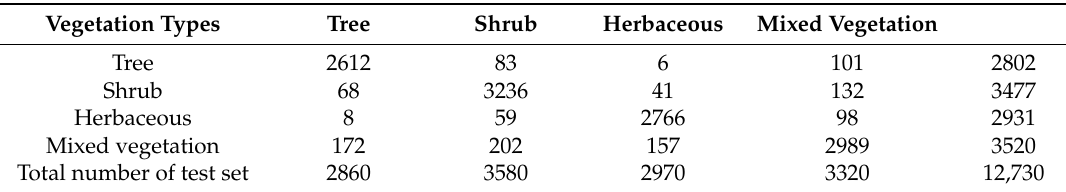
Table 1. Confusion matrix of vegetation